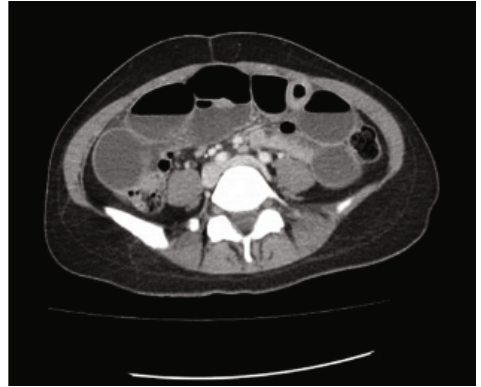
Figure 2: Abdominal computed tomographic scan showing dilated small bowel loops with air fl uid levels.